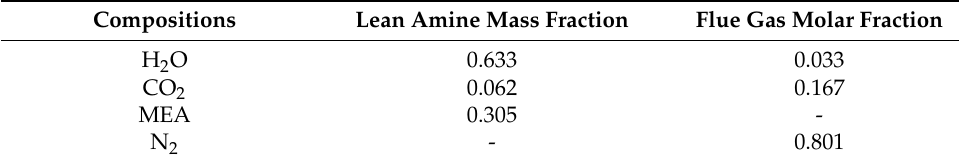
Table 3. Stream composition in base case.